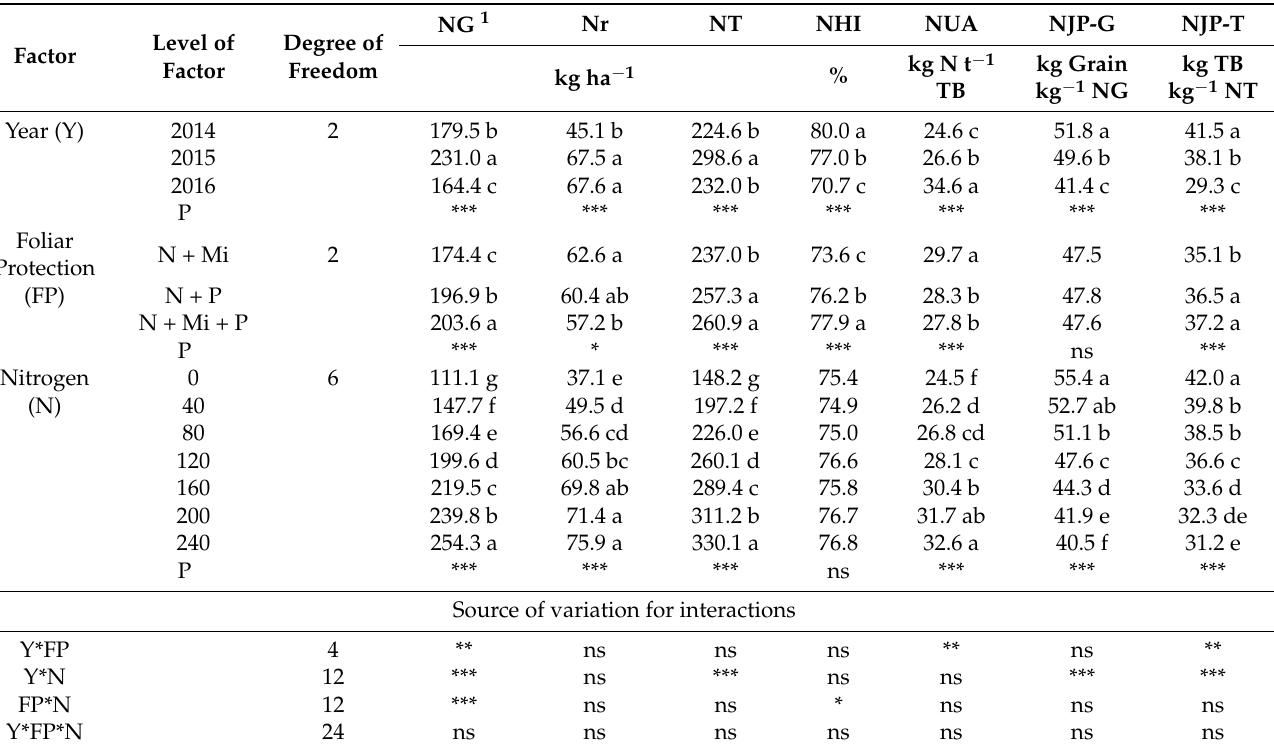
Table 5. Statistical evaluation of factors affecting nitrogen accumulation and basic indices of nitrogen use